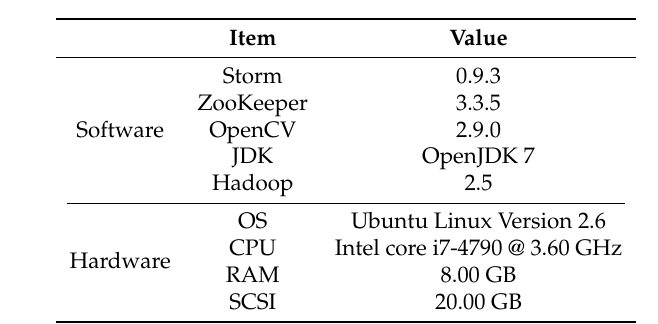
Table 3. Configurations.